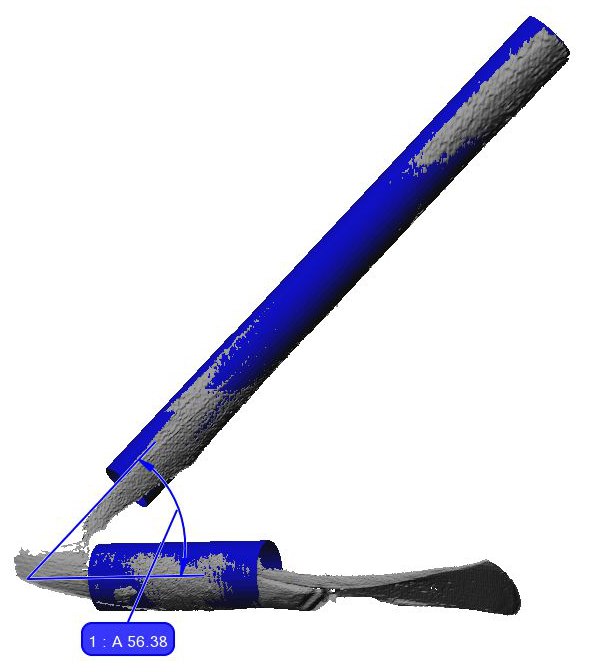
Figure 5. Hand Tool Nr.2 – The angle between the head and the adze handle (in degrees); the blue cylinders were created by “Best Fit” method and the axes of these cylinders were used during the angle calculations